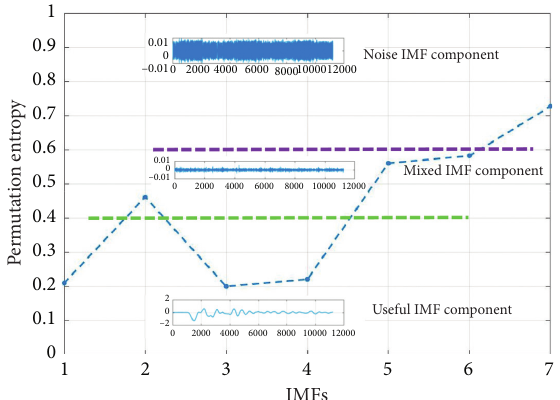
Figure 10: Classification of IMF components according to PE values.